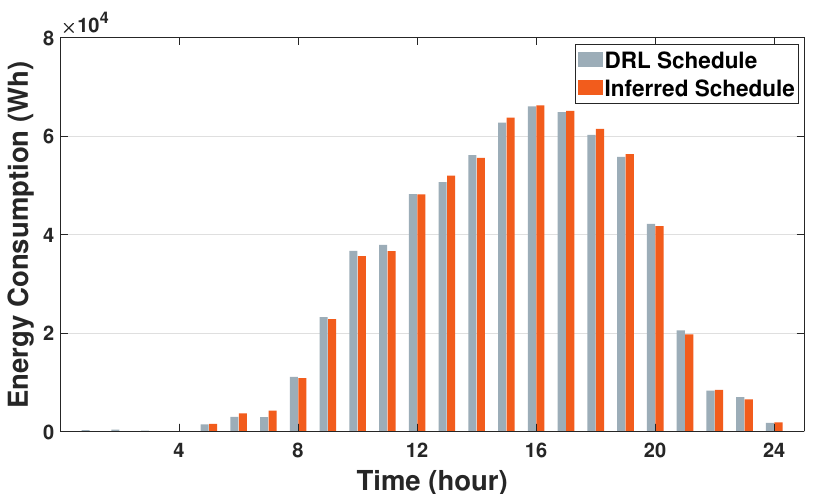
Figure 10. Comparison of the sum of energy consumption schedules for three buildings using the energy consumption schedule ( E HVAC ) of DRL HVAC agents and using the inferred energy n , t ) ) of DRL SESS agent. consumption schedule ( (cid:98) B n ( S HVAC n , t